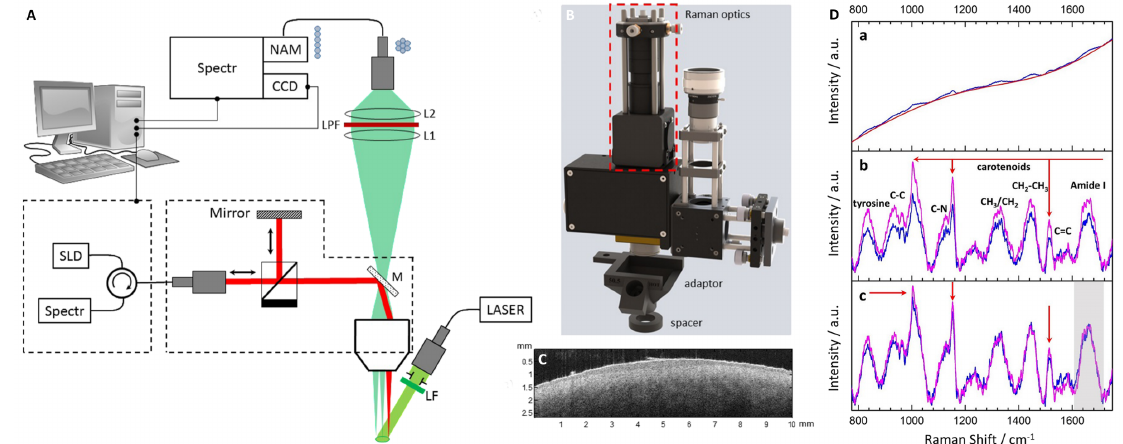
Figure 32. Synopsis of the setup comprising Raman spectroscopy and OCT in the same device. Panel A shows a schematic and B a photograph of the device. Panels C and D present an OCT image and Raman spectra respectively which were obtained from in vivo human skin via the combined system. The blue Raman spectrum in panel D was collected from the back of a hand, the purple spectrum originates from the palm. These two spectra are shown as unprocessed data in a, background corrected in b, and furthermore normalized to the Amide I band in c (reproduced with permission from [154]). The OCT system is the same as used for the studies presented in the previous Sections